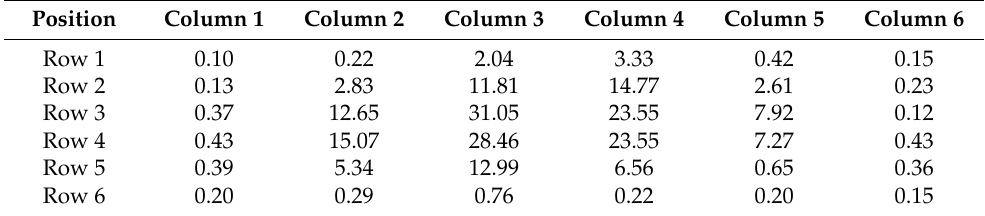
Table 4. Current of the photovoltaic panels.